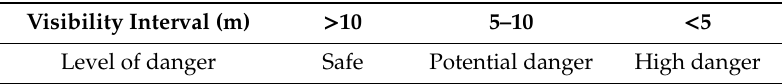
Table 4. Fire visibility parameter